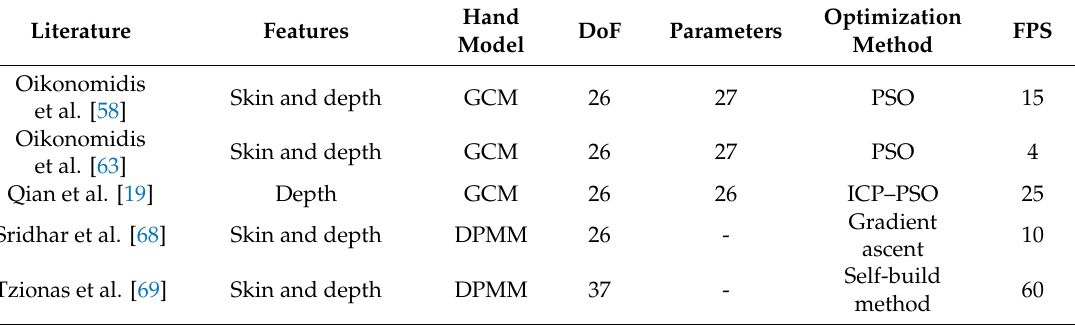
Table 3. Summary of generative methods for hand pose estimation with RGB and depth